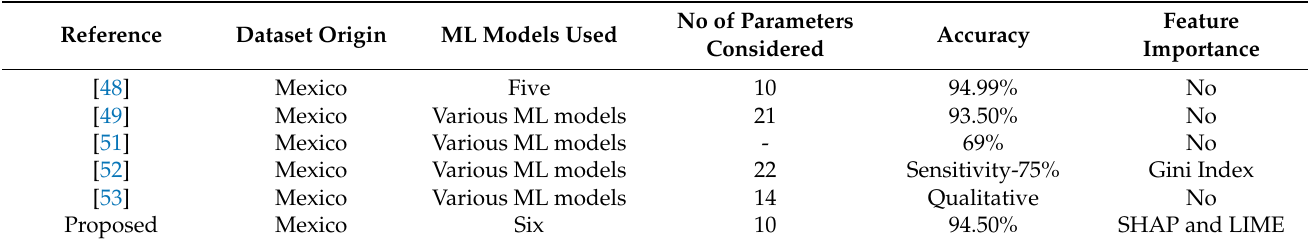
Table 4. Comparison of various researches in diagnosing